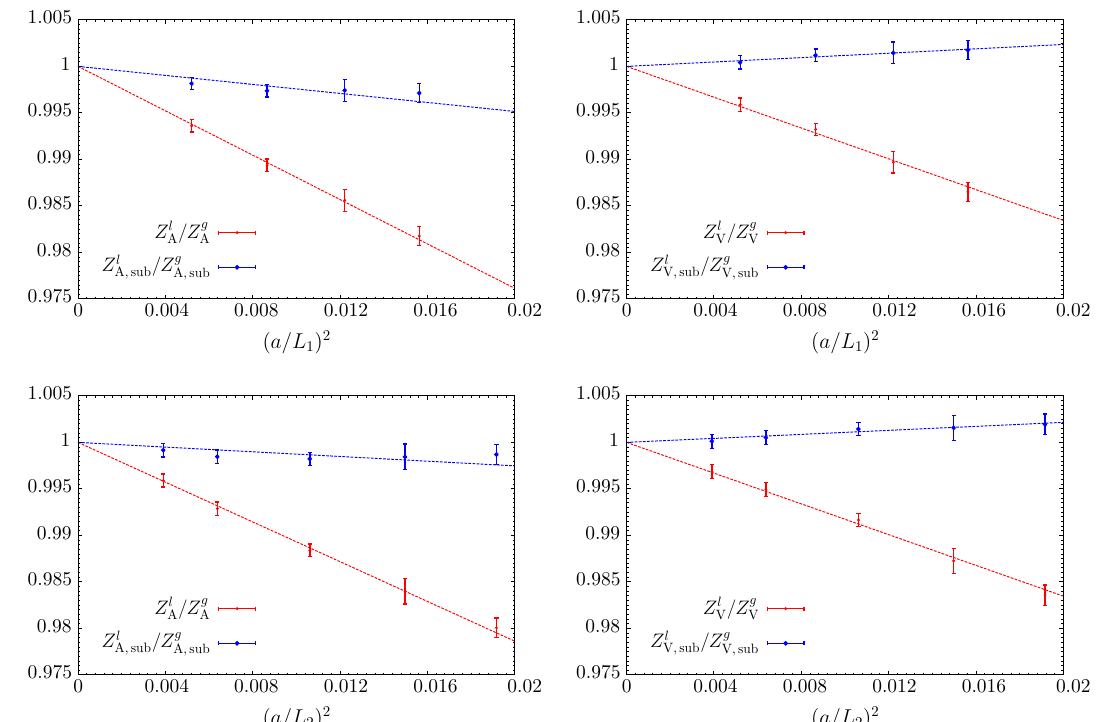
Fig. 7 Continuum limit of the ratios between the l and g definitions of Z A (left panels) and Z V (right panels) for the case of N f = 3 quark- flavours; the effect of subtracting the lattice artefacts from the Z -factors toO( g 2 )isalsoshown.Theupperpanelsshowthe L 1 -LCPresultswhile 0 the lower ones show those of the L 2 -LCP. In all cases, the dashed lines